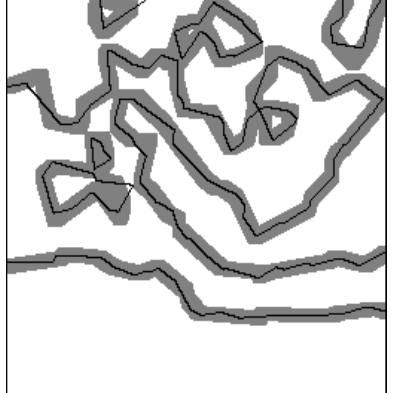
Figure 6. Extracted outlines overlaid on the buffer zones around the outlines of real